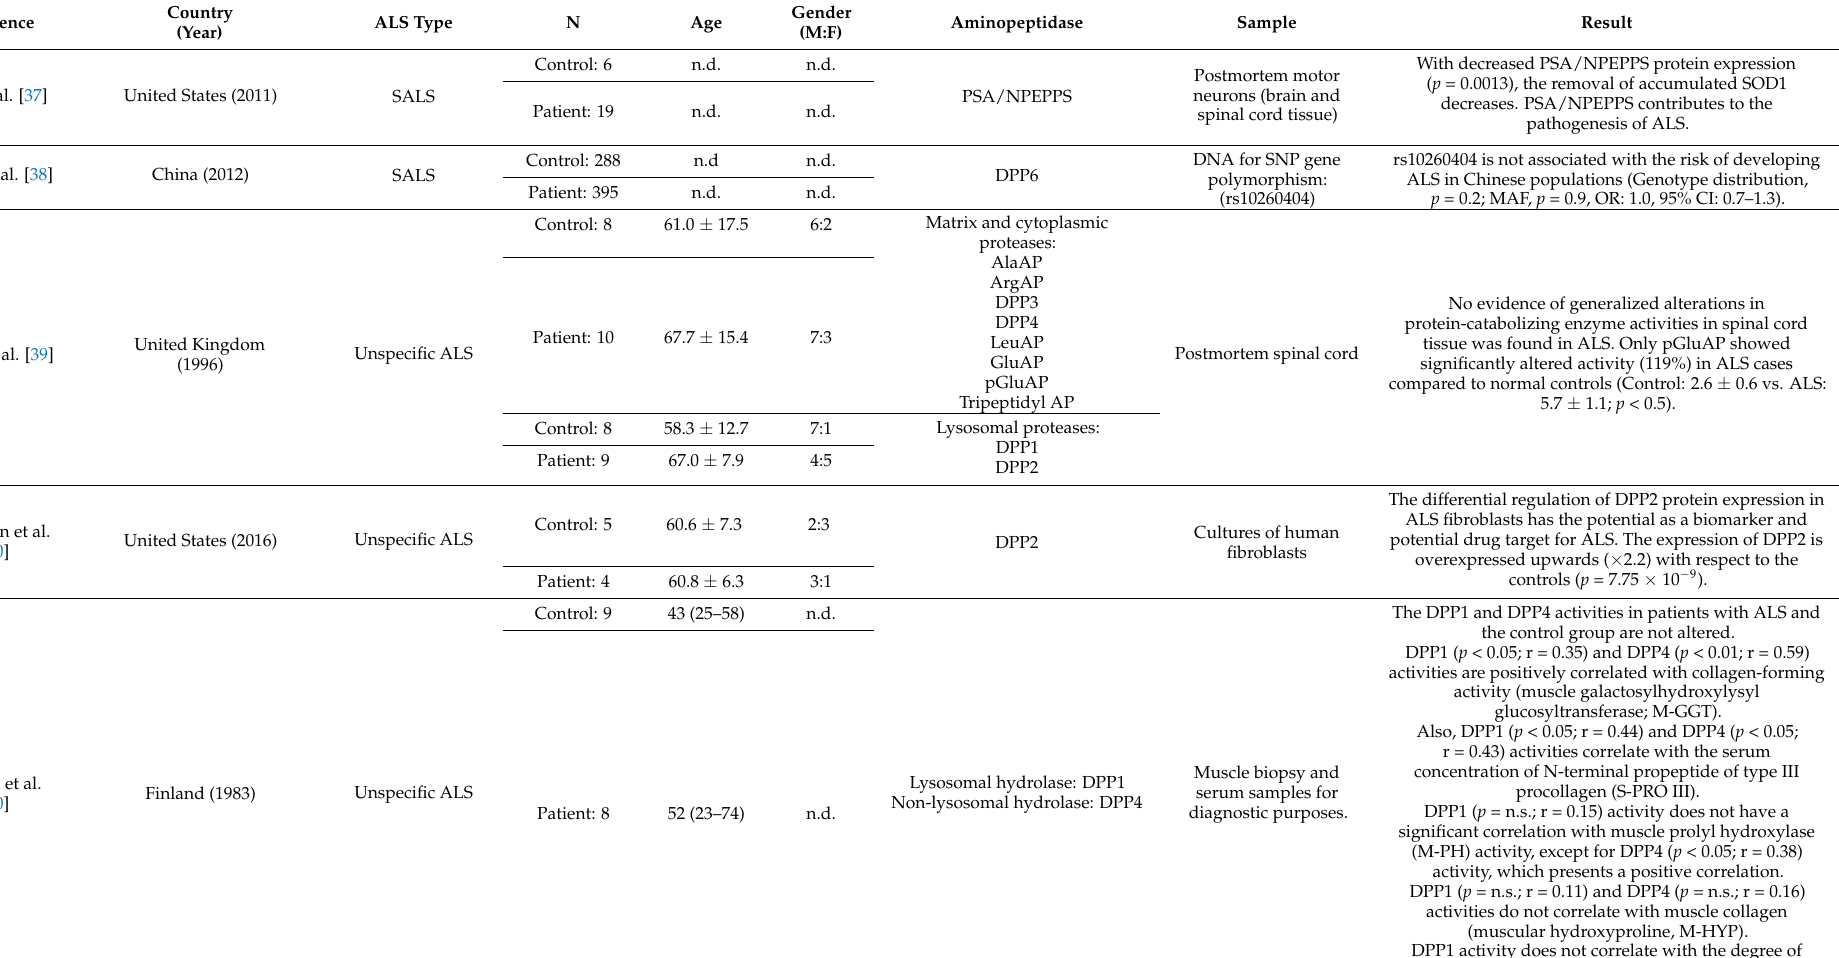
Table 1. Characteristics of the studies included in the systematic review include aminopeptidases as biomolecules for the detection of amyotrophic lateral sclerosis.